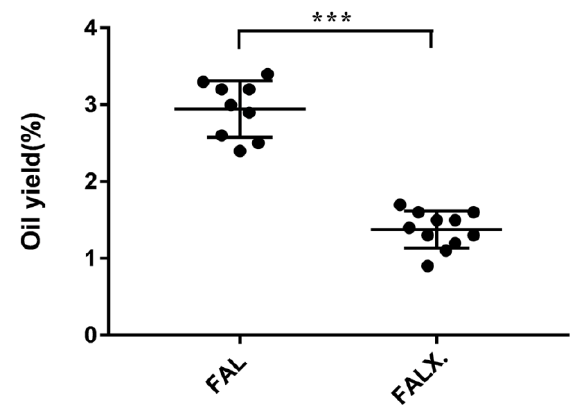
Figure 2. Oil yields of 20 batches of FA from two species. Data were presented as mean ± SEM. *** p < 0.001, compared with Amomum villosum Lour. var. xanthioides T. L. Wu et Senjen (FALX.).